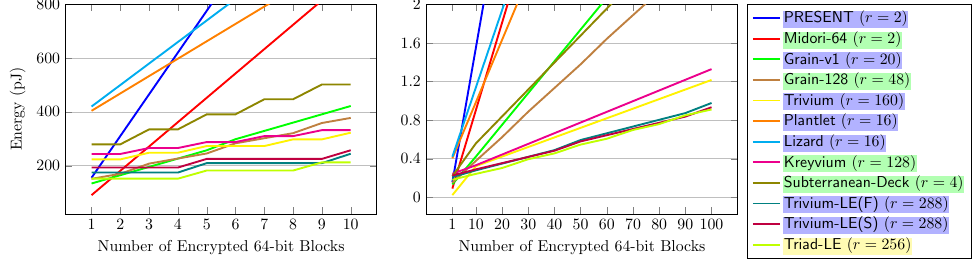
Figure 1: Energy consumption (pJ) chart from Banik et al. [BMA + 18] using the STM 90 nm cell library process at a clock frequency of 10 MHz. Added to the plot are figures for the energy consumptions of Subterranean-Deck , and the designs Trivium - LE ( F ), Trivium - LE ( S ), Triad-LE that we propose in this paper, for the same standard cell library and operating frequency. Figures are reported for short messages (1 to 10 blocks of 64-bits) and longer messages (1-100 blocks). Legend entries highlighted in blue and green have a security level of 80 and 128 bits respectively, whereas Triad-LE offers 112-bit